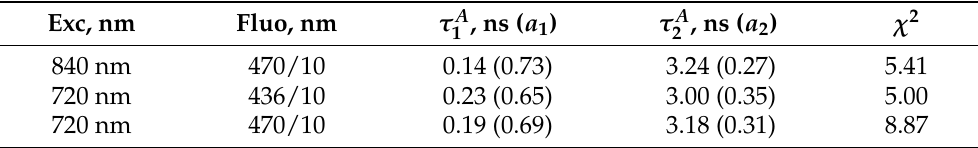
Table 2. Fluorescence decay times τ A using two-exponential